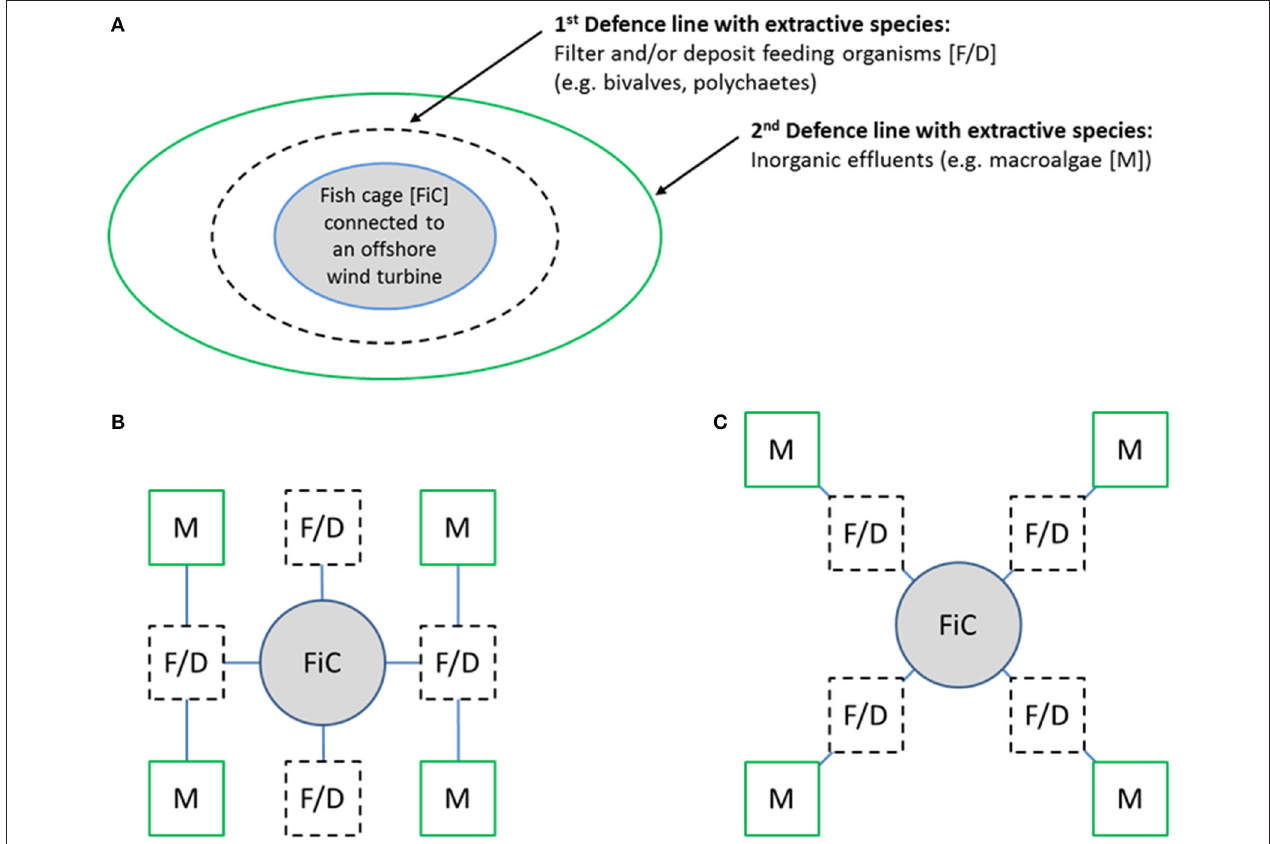
FIGURE 2 | (A–C) Multi-use aquaculture following the IMTA-concept. (A) shows the integration of a central fish cage (FiC) connected to the wind farm foundation with two subsequent “defense lines” including filter/deposit feeding organisms ([F/D] inner circle/black dotted line) and seaweed ([M] outer circle/green line) ( McVey and Buck, 2008) (upper image); (B,C) display different setting options for the combination of a central fish farm (FiC) and the surrounding filter/deposit feeding (F/D) and seaweed (M) farms while at the same time allowing O&M vessels to navigate through the area with direct access to the windmill foundation (bottom left and right).